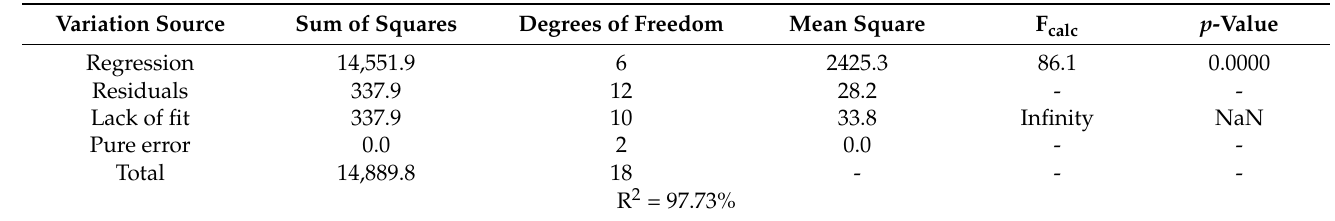
Table 5. ANOVA for the answer (Y 1 ).